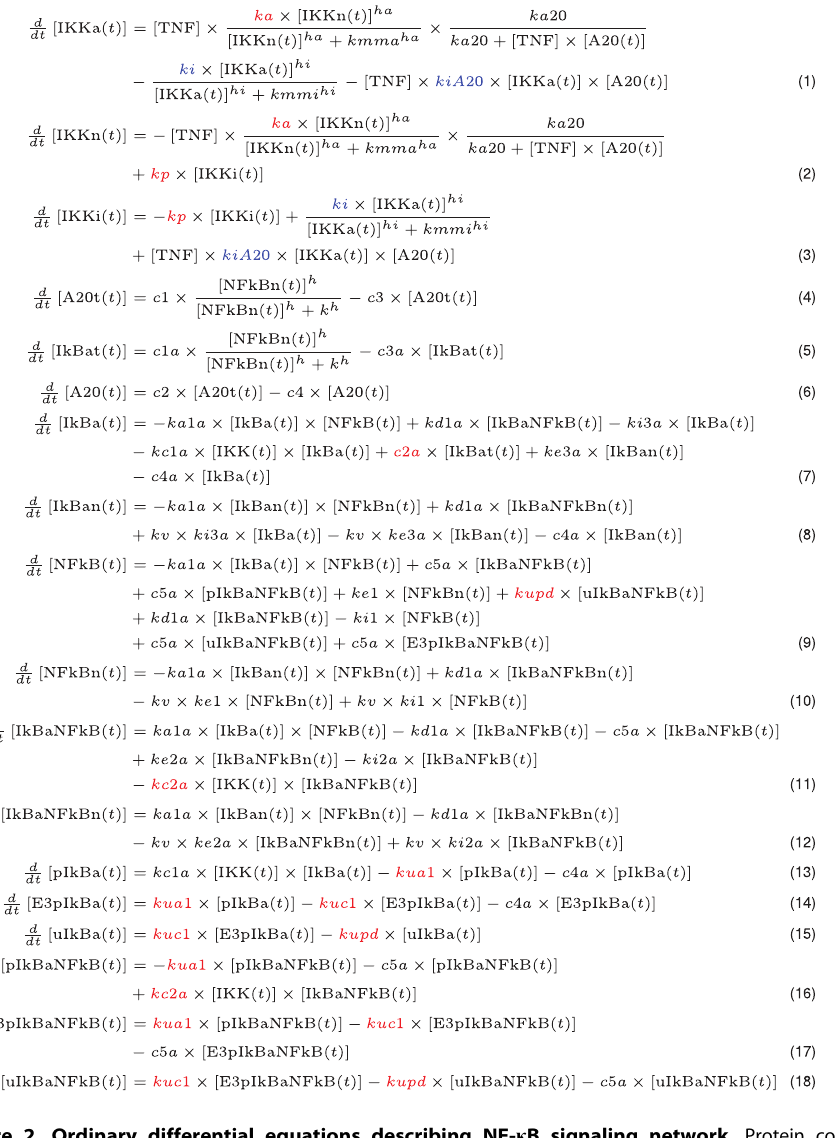
Figure 2. Ordinary differential equations describing NF- k B signaling network. Protein concentrations are denoted with brackets. Parameters altered to simulate reported and hypothetical interactions due to Hsp72 are colored red to denote inhibition and blue to denote enhancement. See also Tables 1 and 2 for biological interpretations of parameter modifications, and Supporting Information Tables S1 and S2 for parameter values and initial conditions used in the